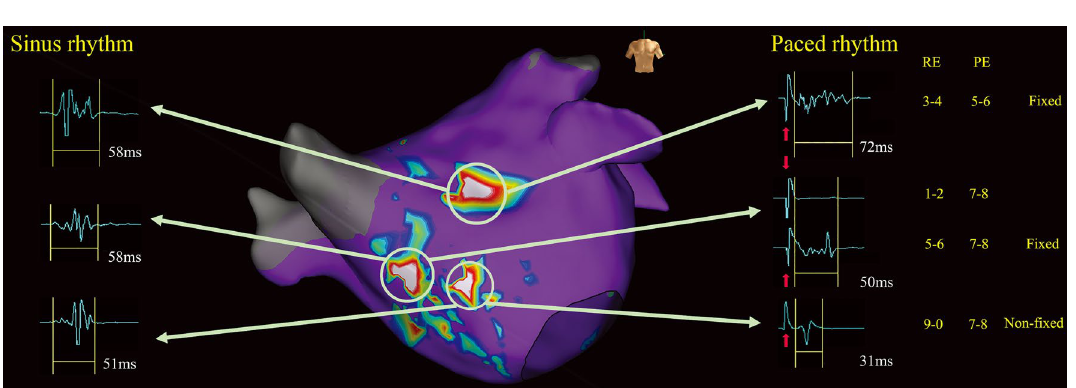
Figure 2. Examples of fixed C-EGMs and non-fixed C-EGMs. Left: Electrograms recorded during sinus rhythm. Middle: A left atrium sinus rhythm fractionation map in anteroposterior view. Right: Electrograms recorded during paced rhythm. Red arrows indicated pacing artifacts. Note the middle electrograms. Pacing artifact merged with the electrogram of interest (electrodes 5–6) and it was difficult to identify the onset of the electrogram. The pacing artifact recorded in electrodes 1–2 was clear and was used as a reference to measure the electrogram of interest. (Graphics software: Ensite Velocity and Microsoft Office PowerPoint v16.0). C-EGMs, complex electrograms in sinus rhythm; PE, pacing electrode; RE, recording